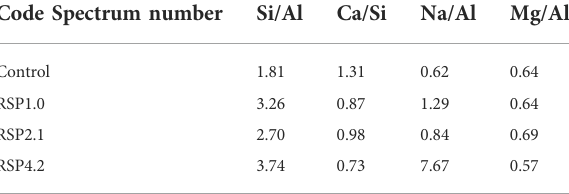
TABLE 4 EDS determination of atomic